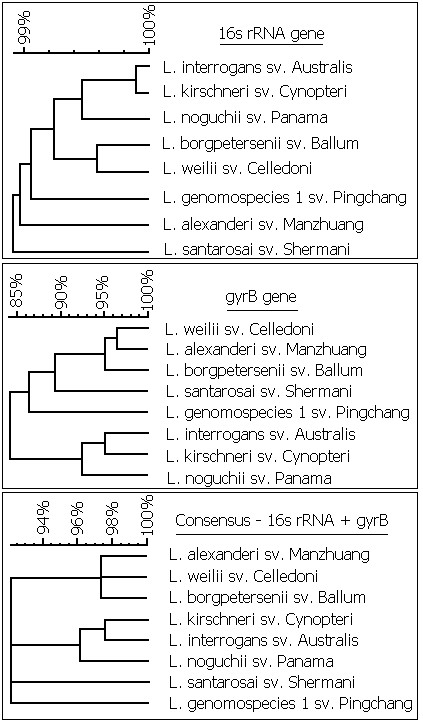
Global cluster analysis of the 16s rRNA gene, gyrB and consensus DNA sequences performed using the UPGMA algorithm.